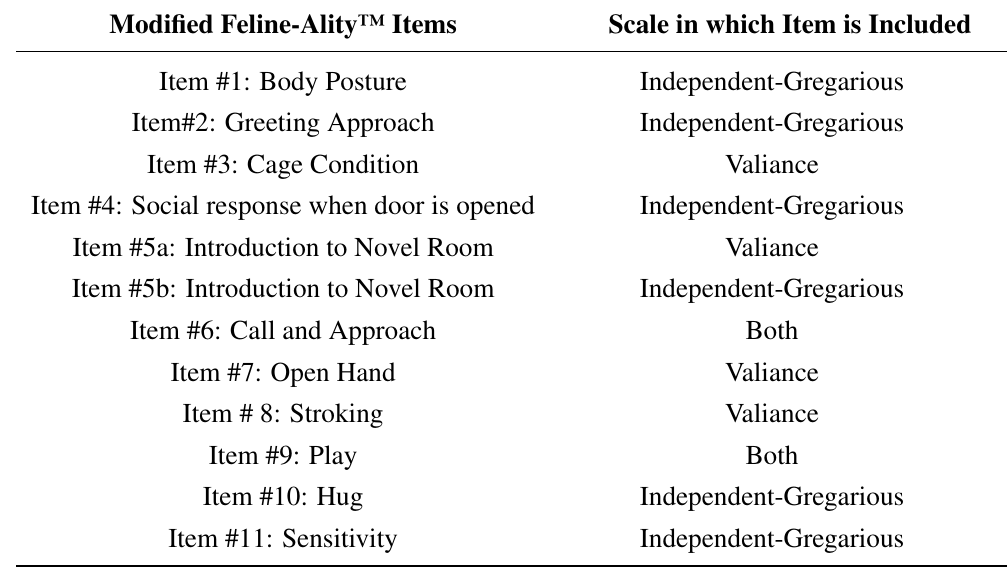
Table 2. Modified ASPCA ® Meet Your Match ® Feline-ality™ Assessment Items and Scales to which the items contribute.